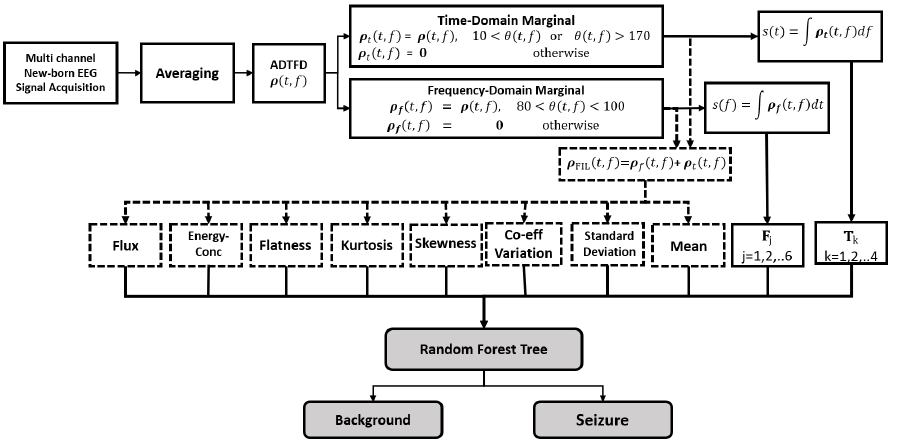
Figure 1. Illustration of the proposed system for detection of seizures in newborn EEG